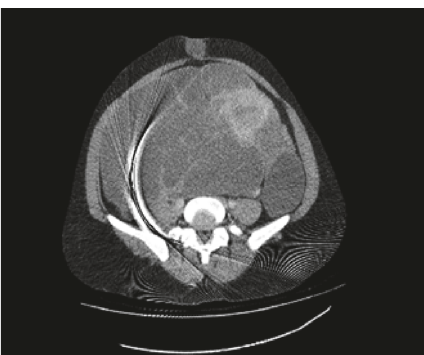
Figure 1: Intravenous contrast CT scan showing a large septated solid-cystic mass with report of serous cyst adenoma.